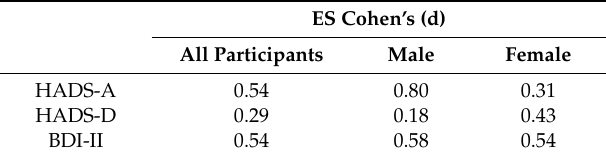
Figure 4. Patterns of MRSs during RF. ( A – C ) All participants; ( D – F ) subgroup male and female. Data presented in mean and SEM. * p < 0.05; ** p < 0.01. Table 5. Cohen’s ES of MRSs between T1 and